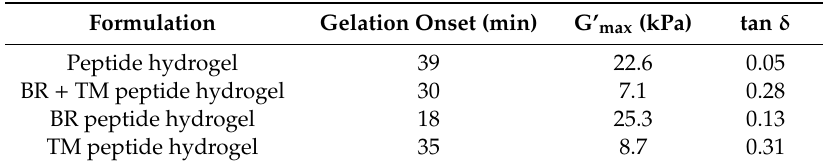
Figure 1. (A ), ( C ). Oscillatory time sweep (0.5% strain, 1 Hz, 37 °C) and ( B ), (D ). frequency sweep experiments (0.5% strain, 0.1–100 Hz, 37 °C) of the ac-(RADA) 4 -CONH 2 peptide hydrogel and the single (BR, TM) and dual (TM + BR) drug loaded peptide hydrogel. Table 1. Rheological parameters of the peptide hydrogel prior and post drug loading (0.5% strain, 1 Hz, 37 °C).